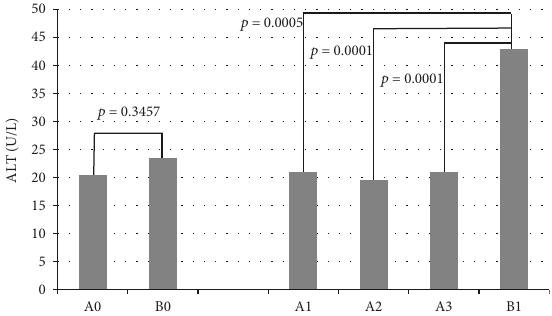
Figure 2: Comparison of the in fl uence of di ff erent models of intravenous methylprednisolone IVMP therapy on ALT — median values and statistical signi fi cance using Mann – Whitney U test ( p values after Bonferroni correction are signi fi cant if < 0.0083). A0 — before treatment; A1 — after administration of 0.5g IVMP; A2 — after administration of 3.0g IVMP; A3 — after administration of 4.5g IVMP; B0 — before treatment; B1 — after administration of 3.0g IVMP; ALT — alanine aminotransferase (normal range: 7 – 56